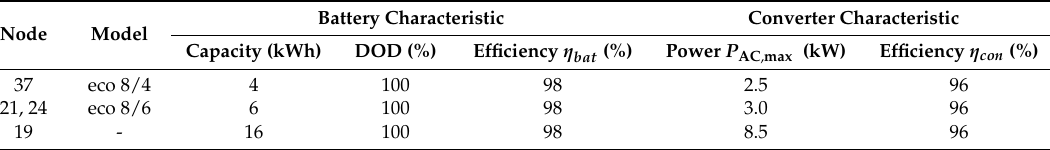
Table 2. Node position and corresponding specification (type, capacity, depth of discharge (DOD), battery efficiency, nominal power and converter efficiency) for the integrated BESSs in the simulation